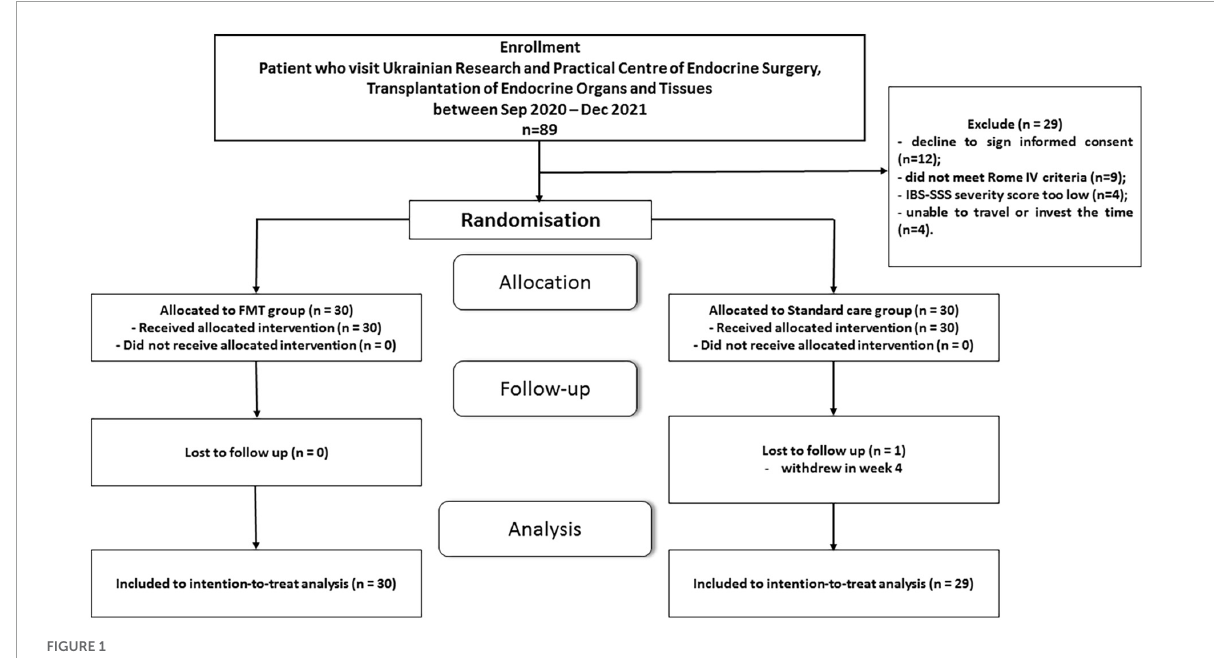
FIGURE1 Consolidated standards of reporting trials (CONSORT) flow chart–trial protocol.